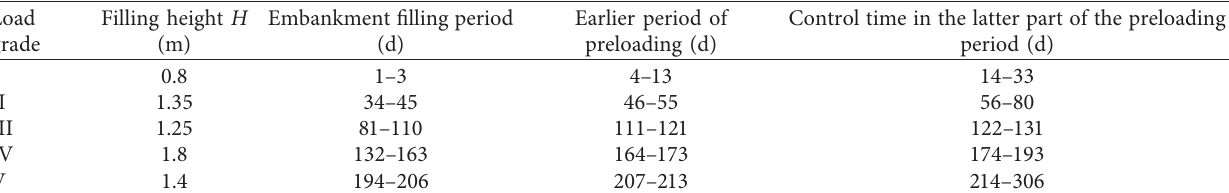
Figure 9: Fill height and settlement varying with time in all stages. (a) Second stage. (b) Third stage. (c) Fourth stage. (d) Fifth Table 2: Construction period in each stage.